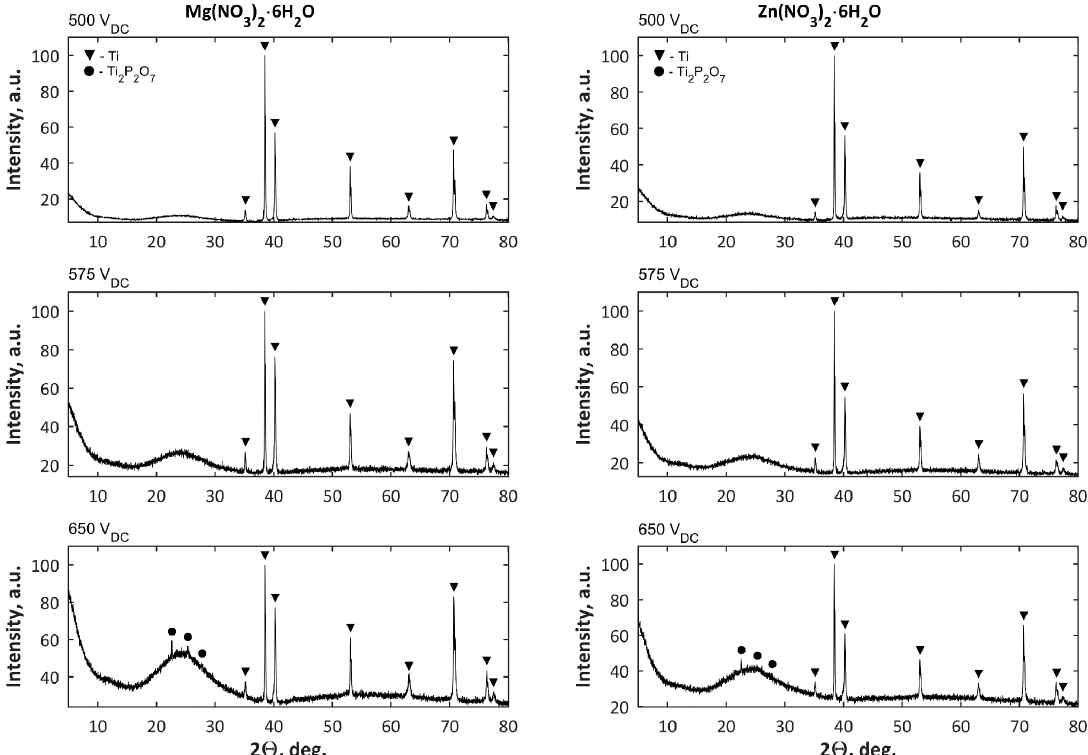
Figure 8. XRD results of coatings after PEO processing obtained in electrolytes composed of Mg(NO 3 ) 2 ·6H 2 O or Zn(NO 3 ) 2 ·6H 2 O in H 3 PO 4 at a concentration of 500 g/L at three voltages, 500 V, 575 V, and 650 V.